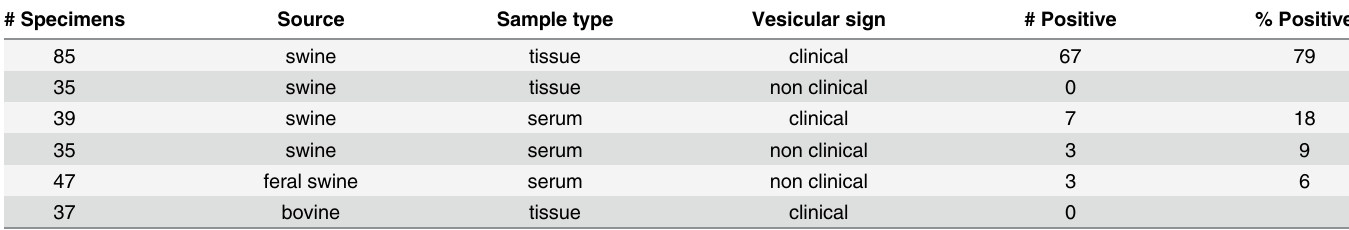
Table 3. Summary of SV-A in various specimen